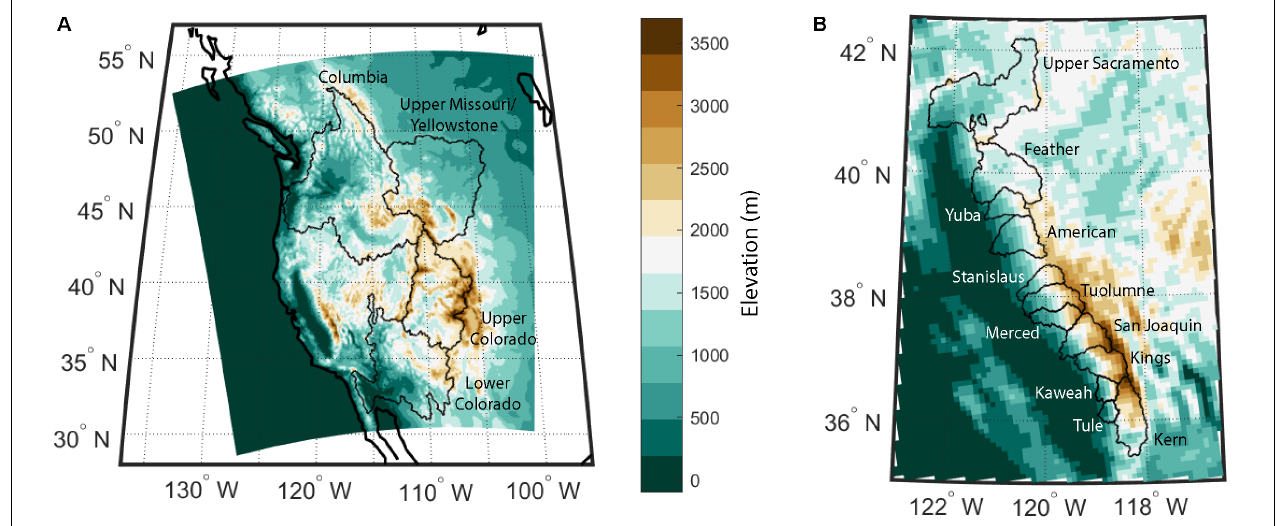
FIGURE 1 | (A) Elevation from 9 km WRF domain over the western United States and Canada. Boundaries of the four large western watersheds are shown in black. (B) Zoomed in elevation, with the same scale, over the Sierra Nevada mountains of California. Twelve basins of interest are outlined in